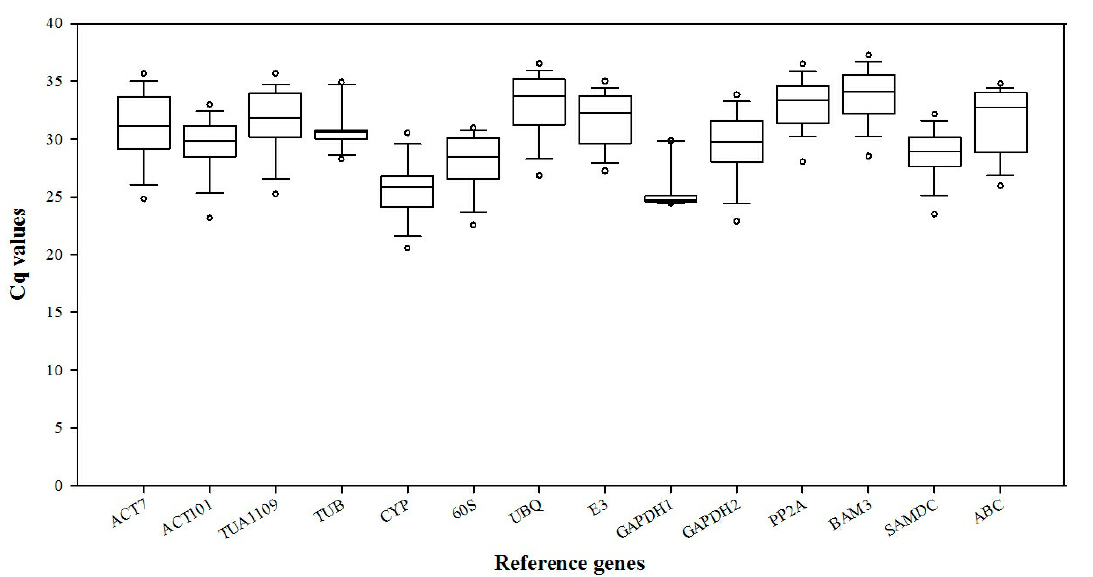
Figure 3. qRT-PCR Cq values for 14 candidate reference genes in white clover leaf and root samples under various abiotic stresses.